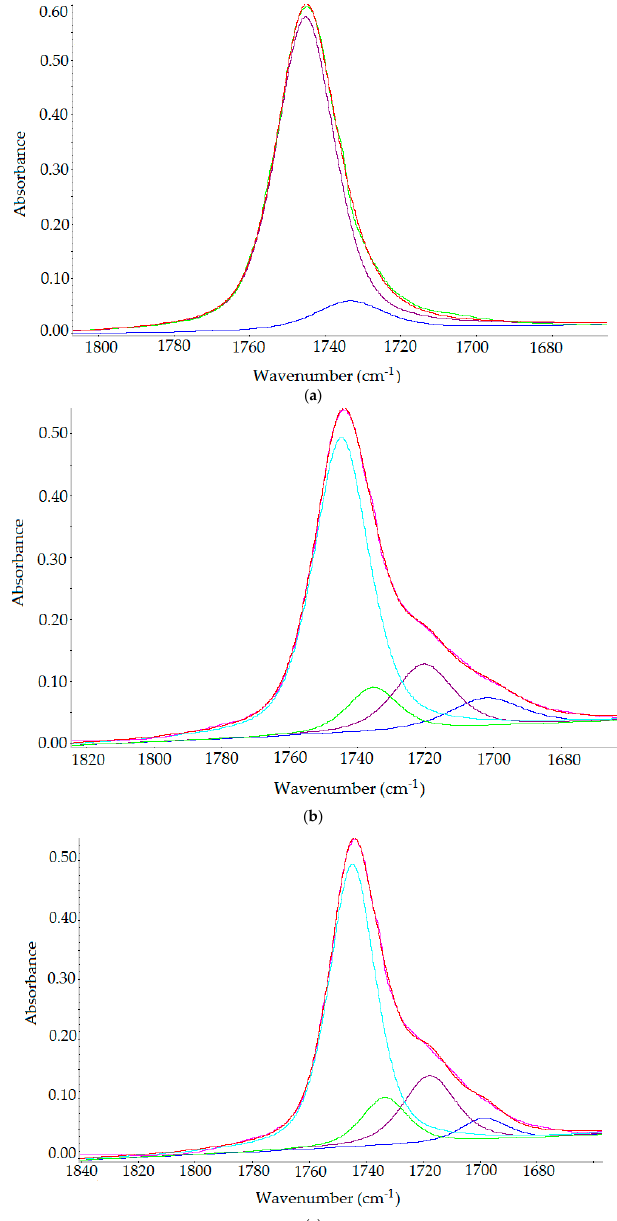
Figure 9. ( a ) Deconvolution of carbonyl bands of raw oil A: 1745 cm − 1 (violet line), 1734 cm − 1 (blue line), original spectrum (green line), total of all deconvolution bands (red line). ( b ) Deconvolution of carbonyl bands of oil A_O 2 : 1745 cm − 1 (sky-blue line), 1735 cm − 1 (green line), 1720 cm − 1 (violet line), 1702 cm − 1 (blue line), original spectrum (pink line), total of all deconvolution bands (red line). ( c ) Deconvolution of carbonyl bands of oil A_CO 2 : 1745 cm − 1 (sky-blue line), 1734 cm − 1 (green line), 1718 cm − 1 (violet line), 1700 cm − 1 (blue line), original spectrum (pink line), total of all deconvolution bands (red